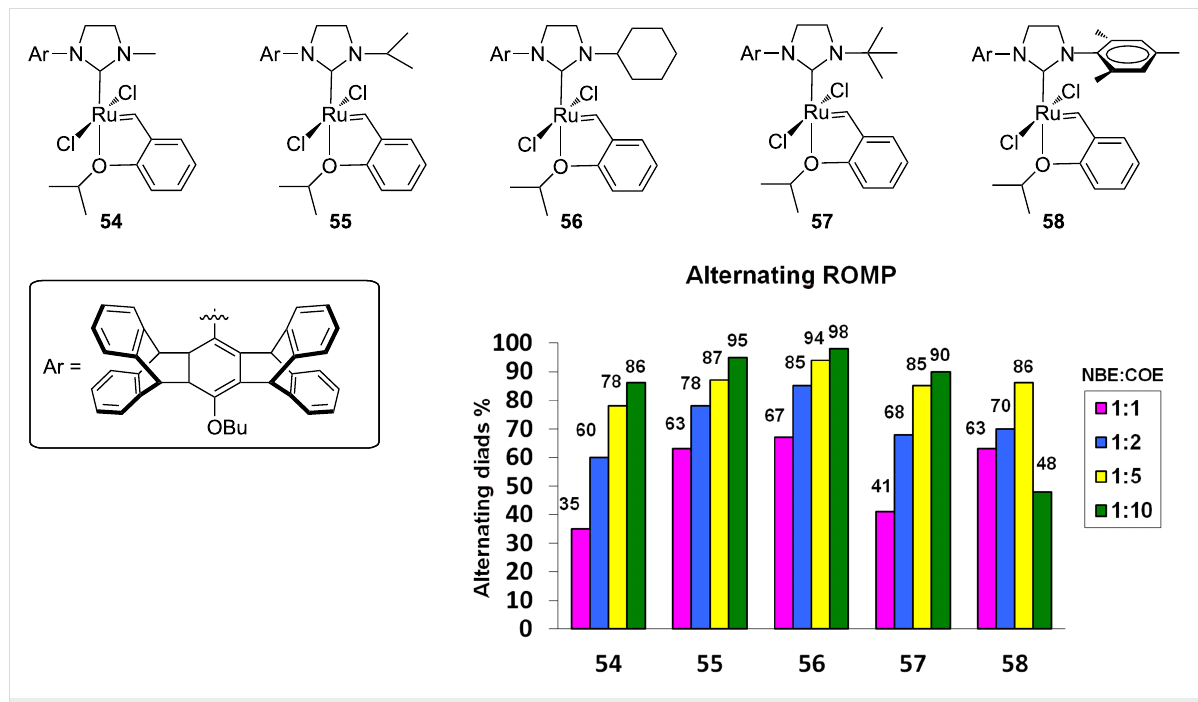
Figure 14: Hoveyda-type complexes 54 – 58 in the alternating ROMP of NBE ( 46 ) and COE ( 47